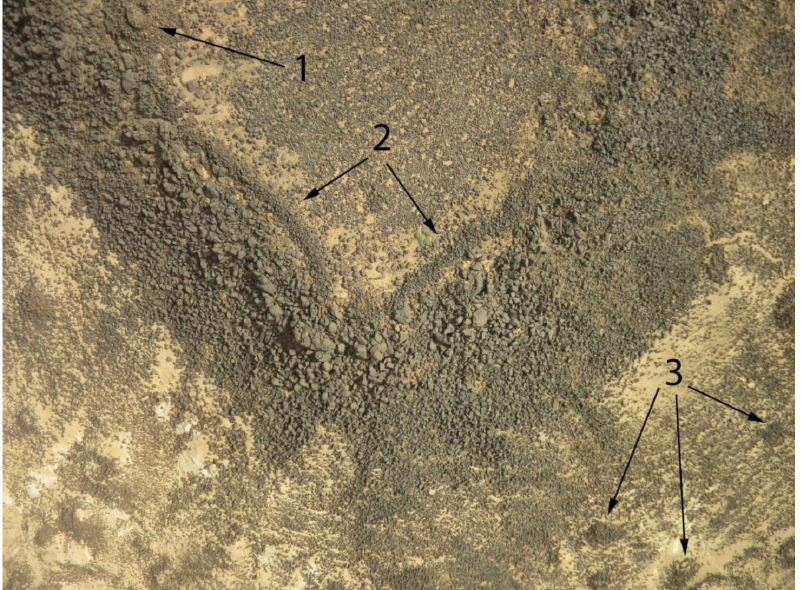
A single overhead image of Mesa 8 from the fixed-wing drone, showing a range of anthropogenic features visible from low-elevation, including (1) tomb, (2) walls, and (3) anthropogenic